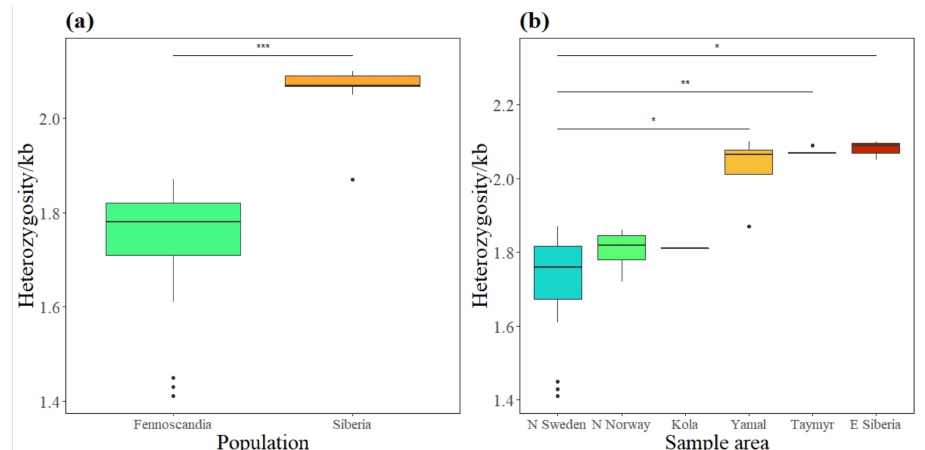
Figure 4. Genome-wide heterozygosity of individuals in northern Fennoscandian and Siberian populations ( a ) and separated into subpopulations ( b ). Heterozygosity measured as the number of heterozygote sites per 1 kb. The horizontal bar shows the median, the boxes show the 25–75% interquartile range and the whiskers show the whole range. Significant results marked with * P < 0.05, ** P < 0.01, *** P < 0.001.